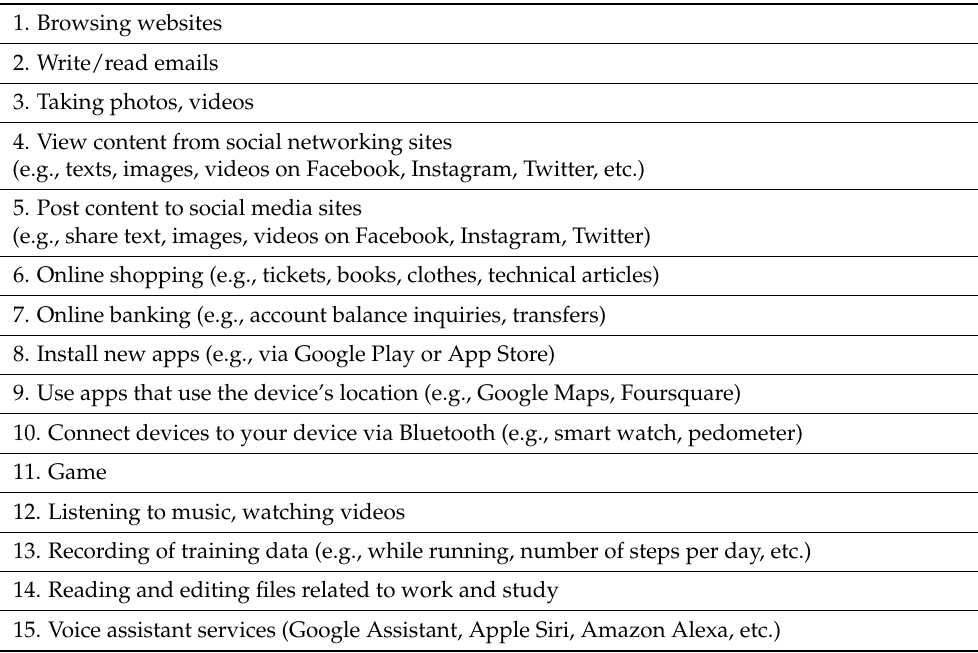
Table A2. Questions of activities, for which the respondent uses their smartphone.